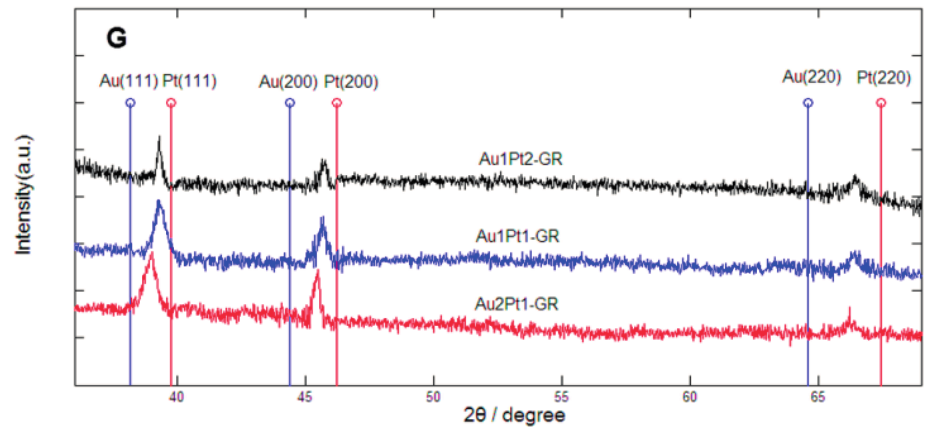
Figure 1. ( A ) SEM image of GR; ( B ) SEM image of AuNPs-GR; ( C ) SEM image of Au1Pt2NPs-GR; ( D ) SEM image of Au1Pt1NPs-GR; ( E ) SEM image of Au2Pt1NPs-GR; ( F ) SEM image of PtNPs-GR; ( G ) XRD patterns of Au1Pt2-GR, Au1Pt1-GR and